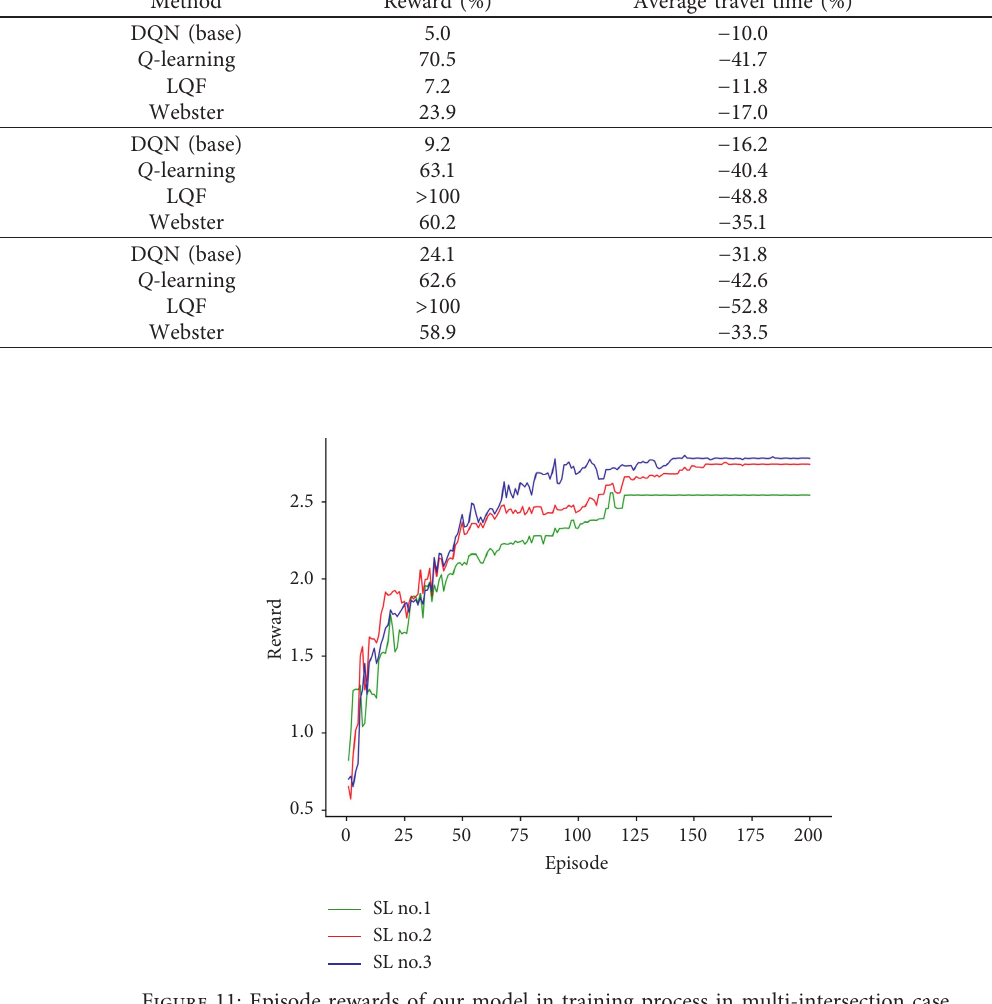
Table 6: Improvements in measures of our model relative to those of other methods for multi-intersection case. SL no.